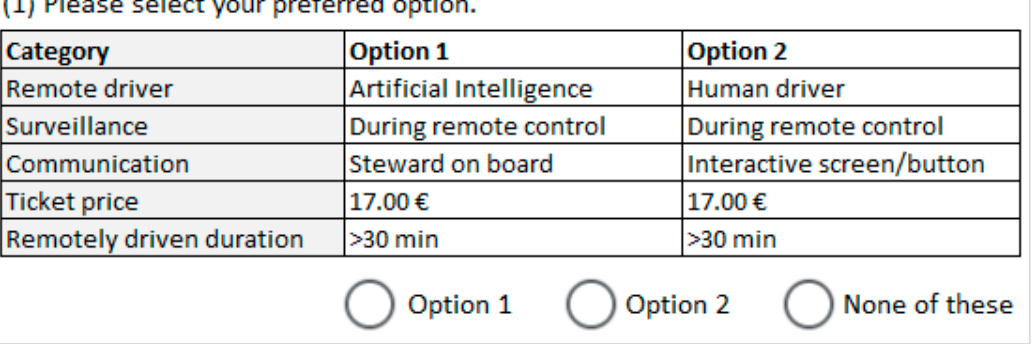
Figure 1. An example of a choice set.